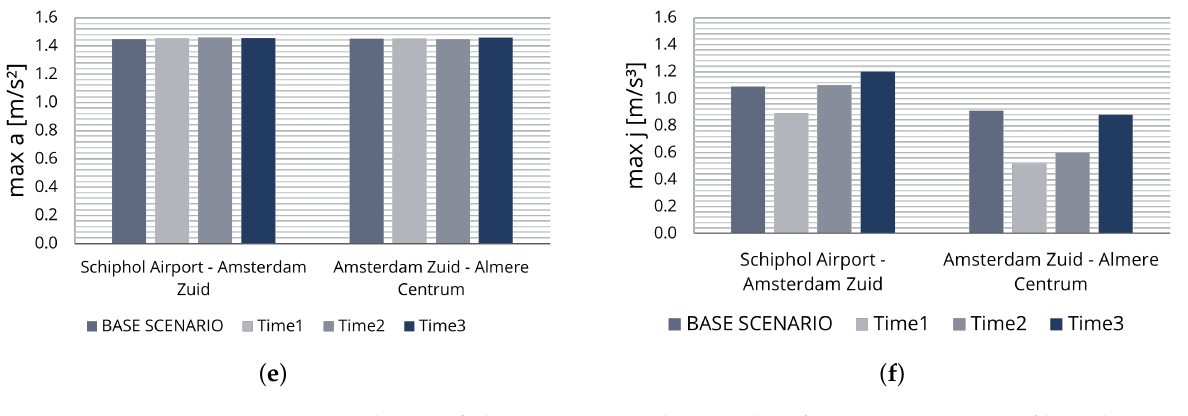
Figure 5. Selection of plots comparing indicator values for concrete scenarios of logical scenario one. ( a ) Arrival delay at stations. ( b ) Stopping accuracy at stations. ( c ) Energy consumption per track part. ( d ) Capacity score. ( e ) Maximum acceleration per track part. ( f ) Maximum jerk per track part.